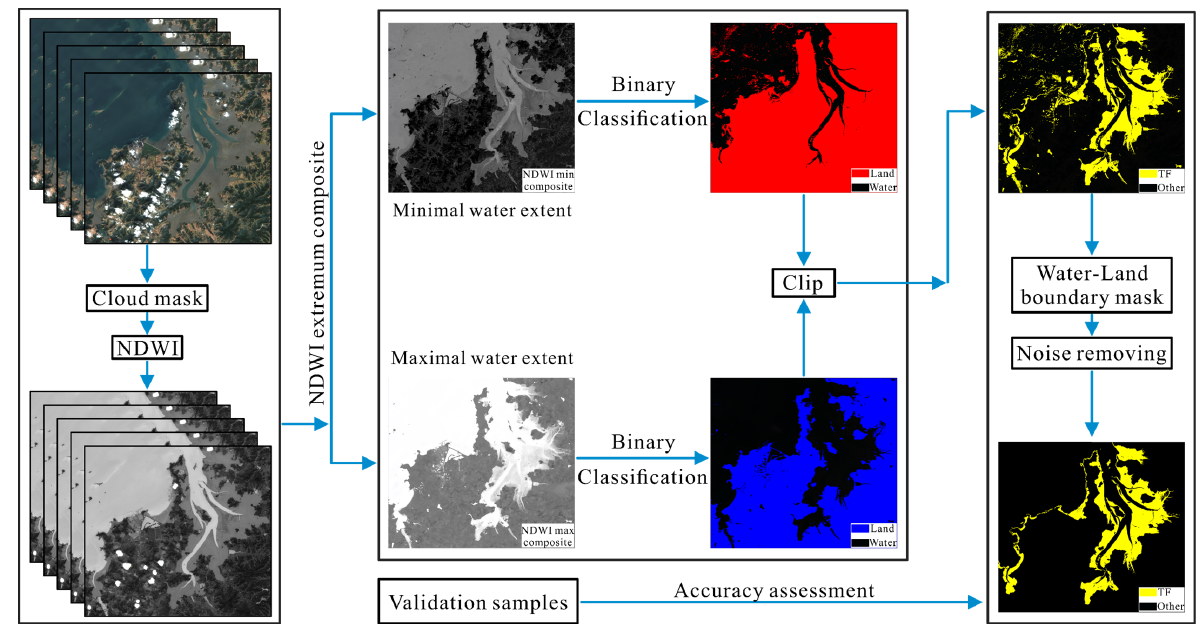
Figure 2. Workflow of tidal flat mapping in this study. TF: Tidal flats.